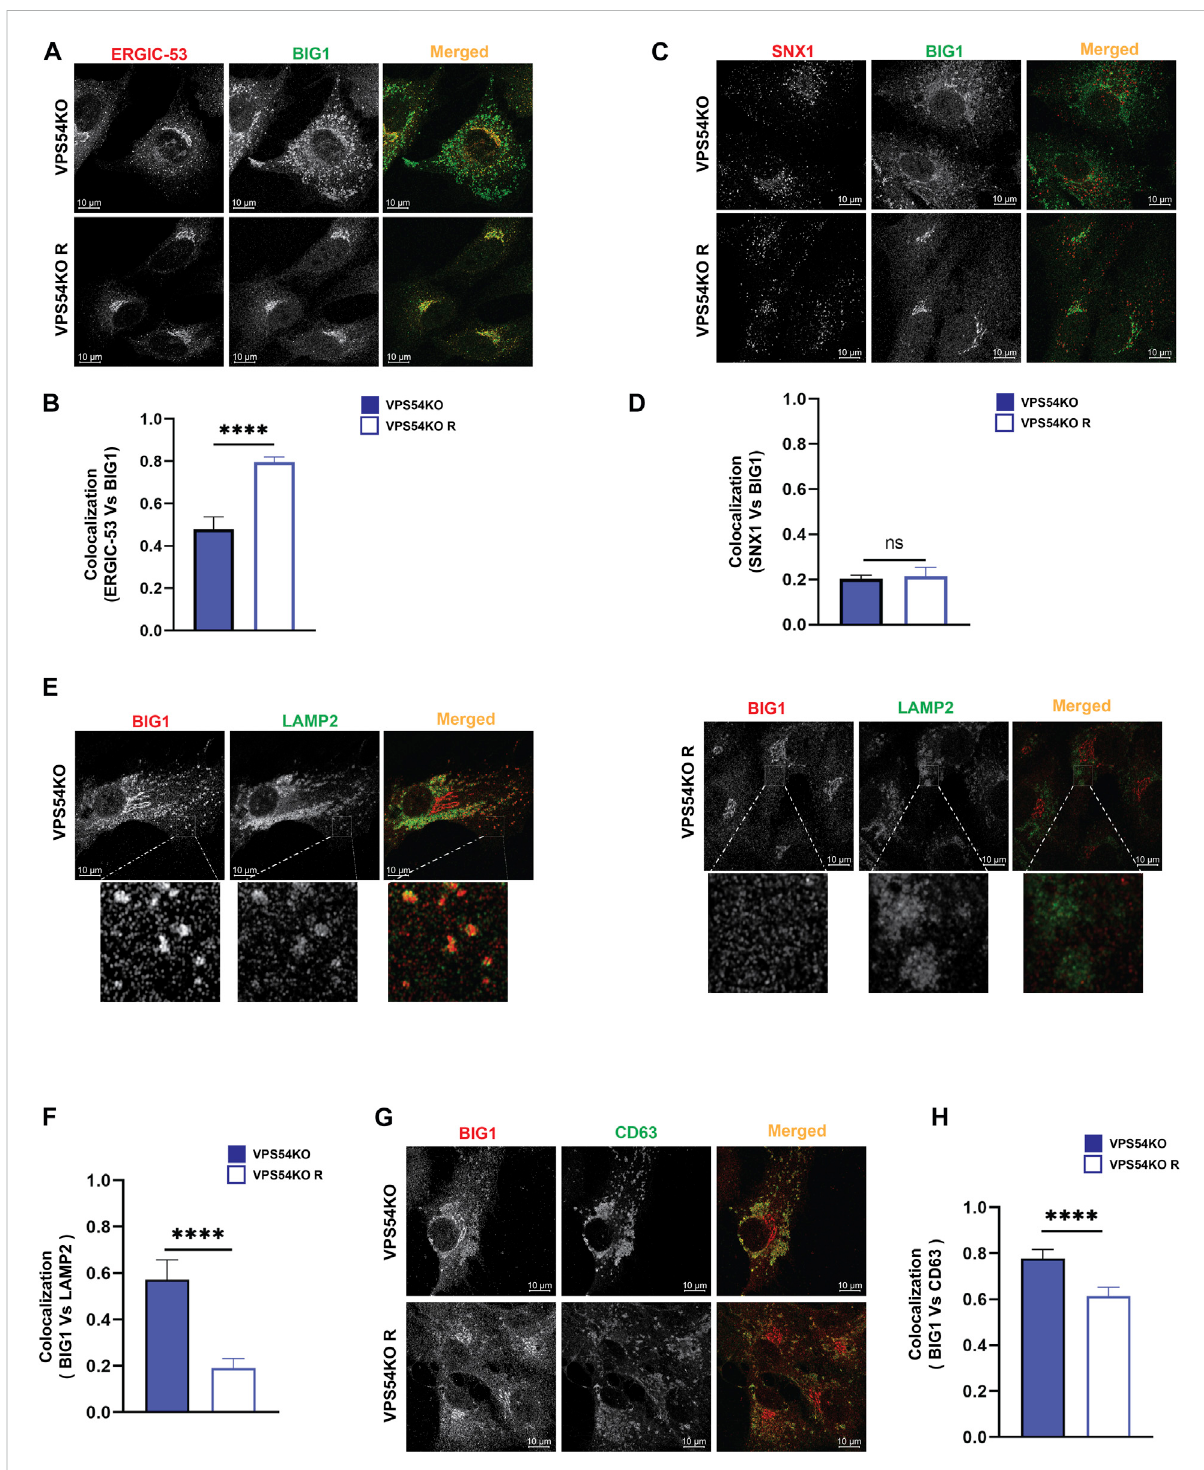
FIGURE 11 BIG1 is mislocalized to endolysosomal compartment in GARP-KOs. Airyscan microscopy of VPS54KO and VPS54KO R cells co-stained for BIG1andERGIC-53 (A) ,BIG1andSNX1 (C) ,BIG1andLAMP2 (E) ,BIG1andCD63 (G) .Thesmallsquareboxin (E) leftandrightpanelindicatesenlarged images.Colocalization analysisbetweenBIG1andERGIC-53 (B) ,BIG1andSNX1 (D) ,BIG1andLAMP2 (F) ,BIG1andCD63 (H) byPearson ’ scorrelation coef fi cient analysis. n = 30 cells. **** p ≤ 0.0001, ** p ≤ 0.01.